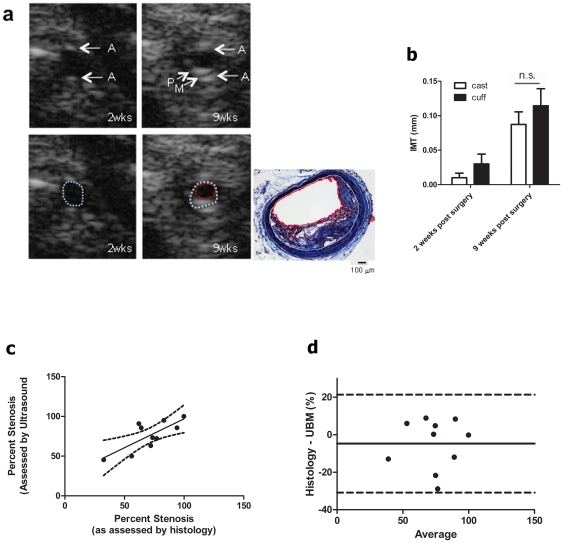
Percent stenosis calculated from UBM parameters correlates with histological measurements.(a) Transverse B-mode image of RCCA 2 and 9 weeks after surgery. Upper Images, Adventitia is marked “A”, plaque “P”, “Medial layer M”. Lower, images are identical, but the inner elastic lamina is outlined with dotted white line, lumen with a red dotted line. Trichrome-stained transverse sections of the same 9 wk artery; internal elastic lamina (IEL) and lumen are outlined in white and red, respectively. (b) IMT measurements of casted and cuffed animals after 2 and 9 weeks of surgery. n.s. Not significant. (c) Linear regression analysis of percent stenosis estimated by UBM and histology. See Materials and Methods for calculations of percent stenosis. Dotted lines indicate 95% confidence intervals; correlation coefficient = 0.75, n = 10 casts. (d) Comparison of UBM and histology measurements using Bland-Altman analysis. Dotted lines indicate 95% limits of agreement. Bias is indicated by solid line, was calculated as −4.76 mm±13.3 SD.